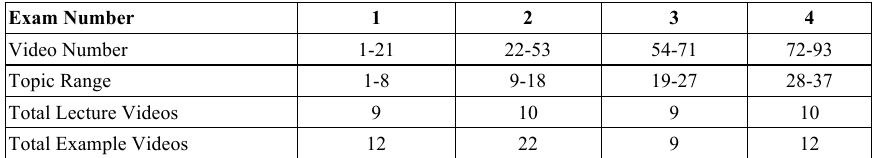
Table 1. Exam cycles and video